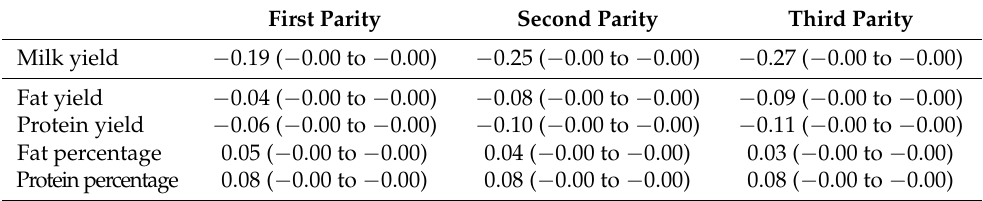
Table 2. Mean (range) phenotypic correlations between SCS and production traits in the first three parities of Iranian Holstein cows.